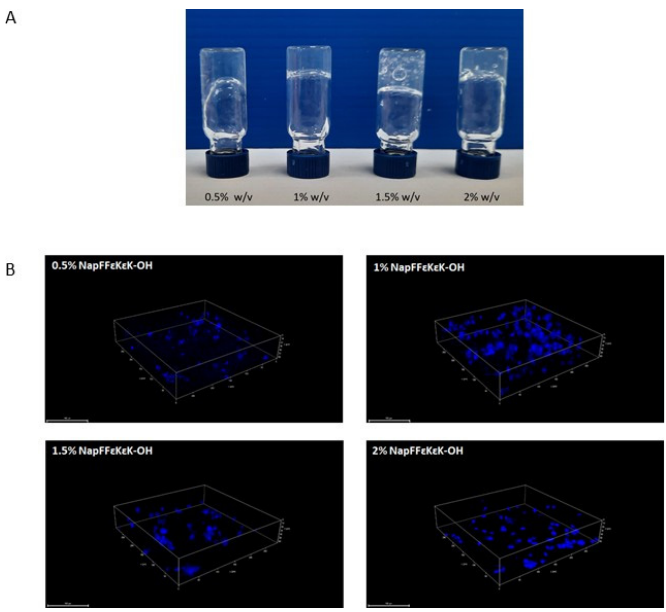
Figure 1. Formulated NapFF ε K ε K-OH hydrogel properties. ( A ) The assembled NapFF ε K ε K-OH hydrogels (0.5–2% w / v ) were shown to be self-supporting. ( B ) Confocal microscopy of DPSCs 24 h after their encapsulation in 0.5–2% w / v NapFF ε K ε K-OH hydrogels, showed that cells were retained in 3D within the hydrogels. Cells were fixed and permeabilised within the hydrogel before staining of the encapsulated DPSC nuclei with DAPI. Images were captured using an SP8 Confocal Microscope. Scale bar: 100 µ